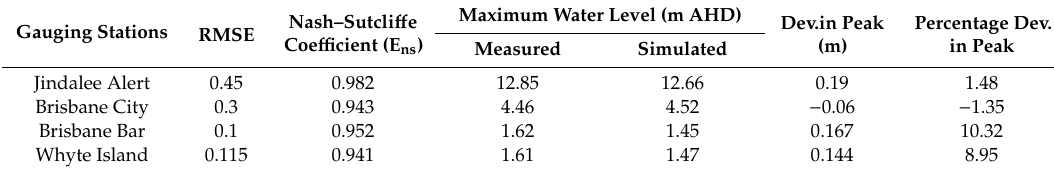
Table 6. Performance indices at gauging stations during validation of the 2011 event.